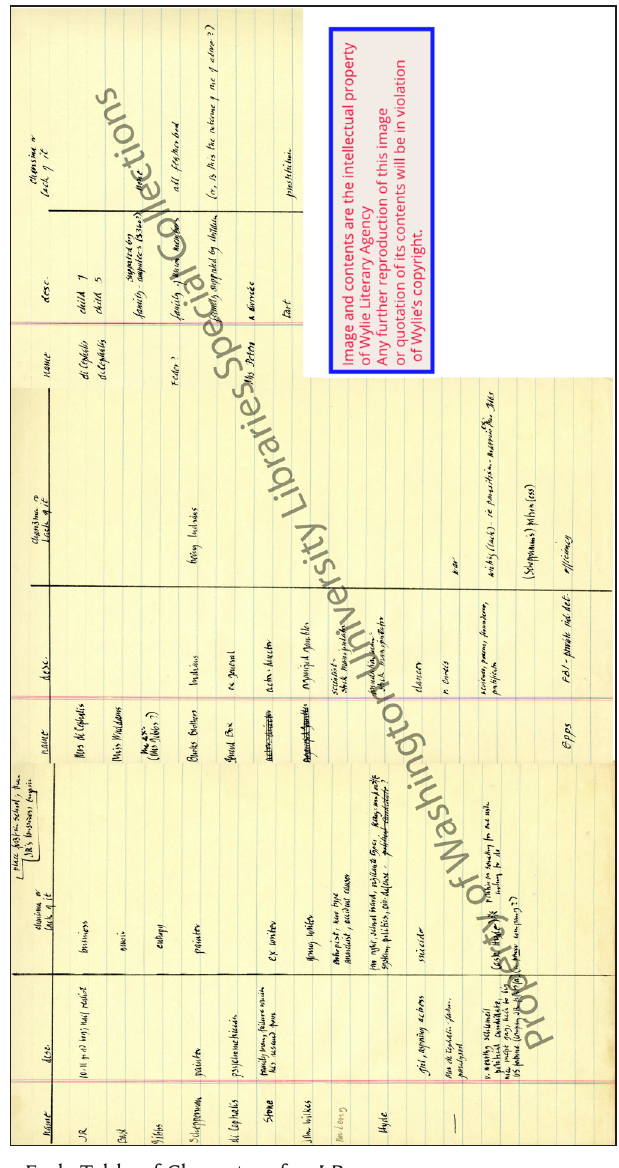
Figure 4: An Early Table of Characters for J R